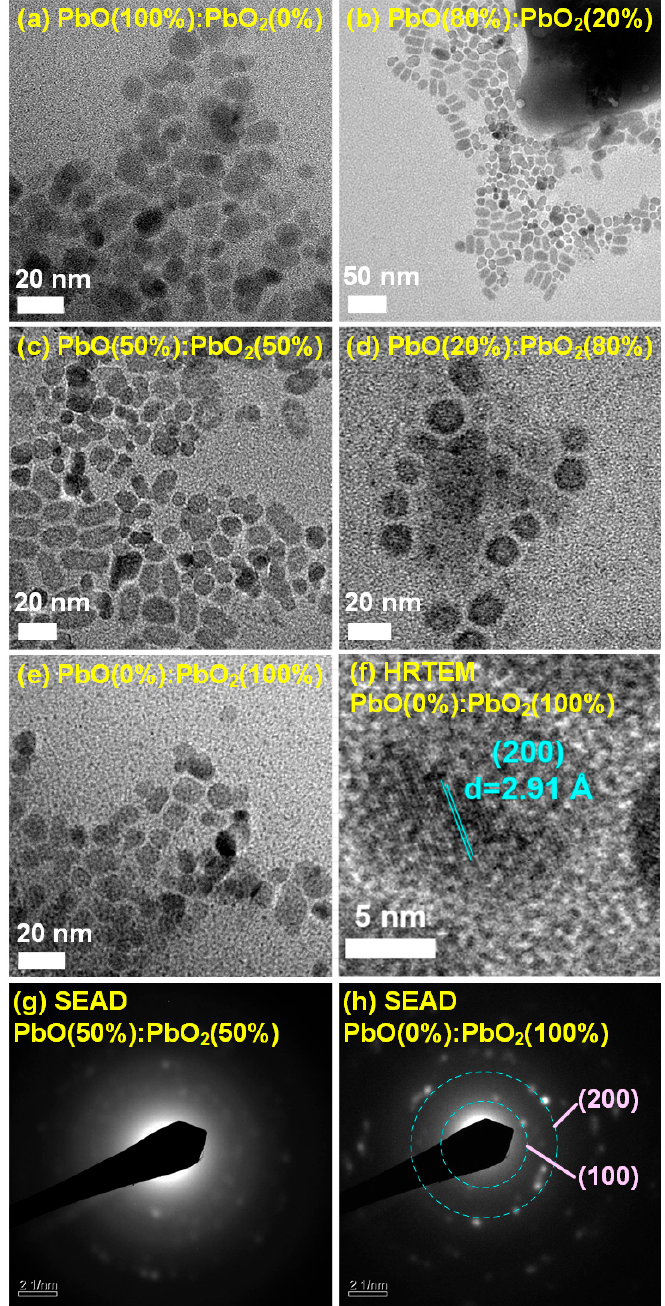
Figure 4. TEM images of CsPbBr 3 -QD films with ( a ) PbO(100%):PbO 2 (0%), ( b ) PbO(80%):PbO 2 (20%), ( c ) PbO(50%):PbO 2 (50%), ( d ) PbO(20%):PbO 2 (80%), and ( e ) PbO(0%):PbO 2 (100%) ratios. ( f ) HRTEM image of the CsPbBr 3 -QD (PbO(0%):PbO 2 (100%)) film. SAED images of CsPbBr 3 -QD films with ( g ) PbO(50%):PbO 2 (50%) and ( h ) PbO(0%):PbO 2 (100%) To obtain the CsPbBr 3 -QDs’ optical properties, the PL spectra for these samples were studied using a fluorescence spectrophotometer system (F-7000, Hitachi, Tokyo, Japan), as shown in Figure 5a. The PL spectral intensity of CsPbBr 3 -QDs decreases as the PbO 2 ratio of waste lead increases.